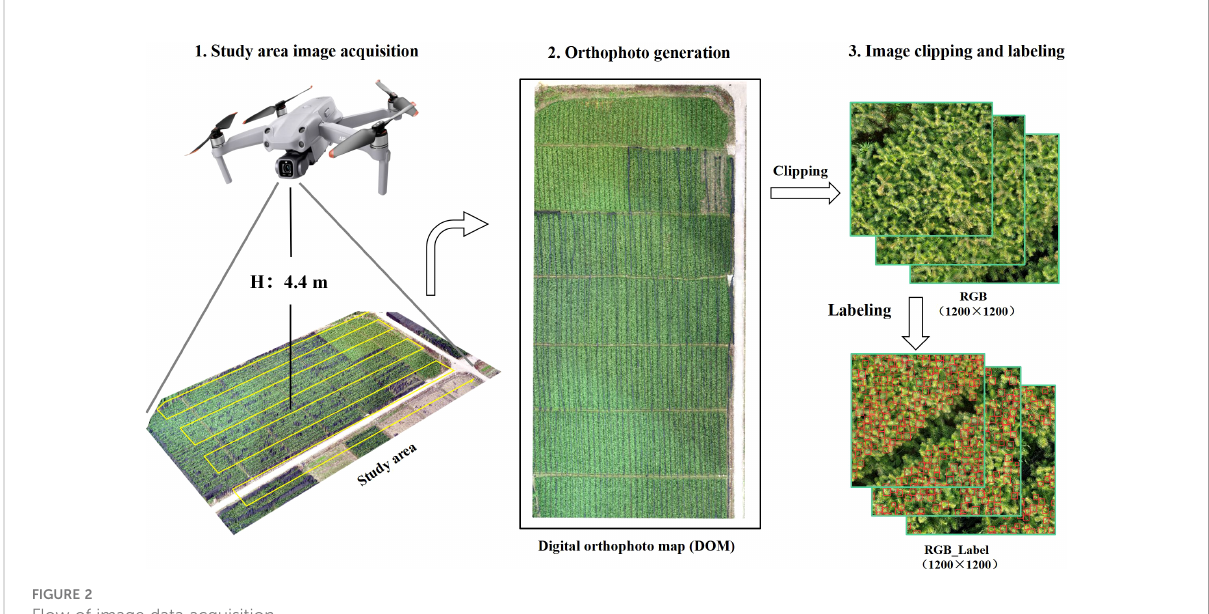
FIGURE 2 Flow of image data